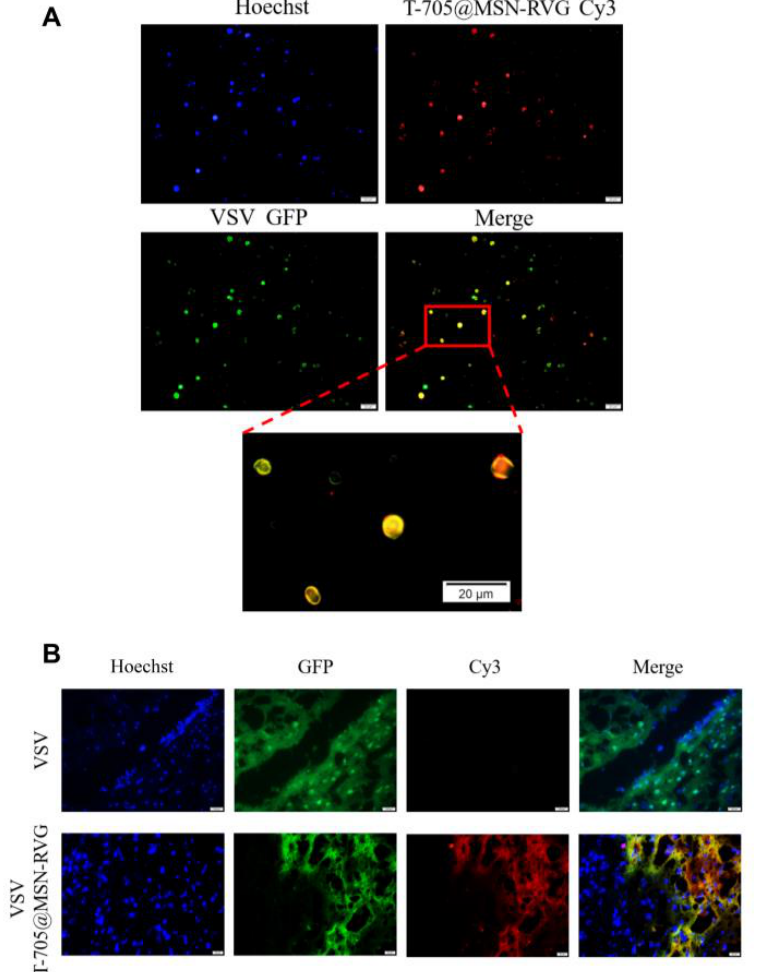
Figure 5. The distribution of VSV and T-705@MSN-RVG in vitro and in vivo. ( A ) N2a cells (VSV-GFP infected at MOI of 1) were incubated with 100 μL of T-705@MSN-RVG (2 mg/mL) at 37 °C for 1 h. After being washed and stained by Hoechst, the cells were visualized by a fluorescence microscope. ( B ) Six- week-old female Balb/c mice were inoculated with VSV-GFP (200 FFU, i.c.) and T-705@MSN-RVG (25 μL at a concentration of 1 mg/mL, i.v.). The fluorescences of Hoechst, GFP, and Cy3 were determined by a fluorescence microscope. Scale bar 20 μm. 2.8. Antiviral Experiments in Mouse Brains by Using T-705@MSN-RVG For the in vivo experiments, the appropriate viral injection dose was first determined by pathogenicity experiments. Nearly 80% of the mice were sacrificed at 21 dpi with 100 FFU of VSV-GFP injection, whereas 100% of the mice were sacrificed under 200 FFU (Figure